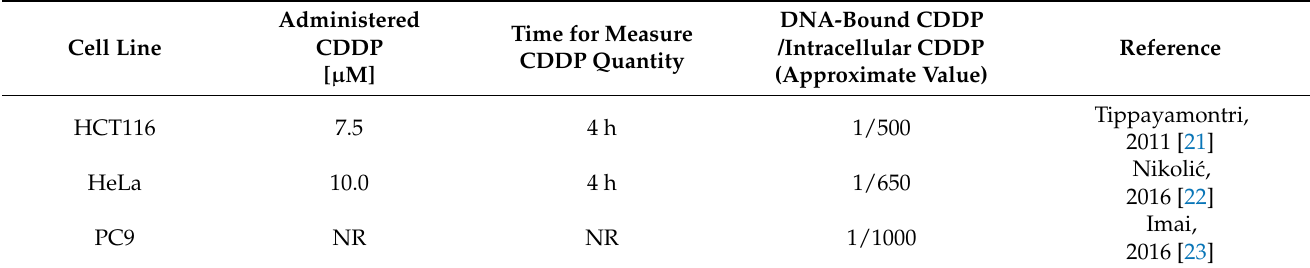
Table 1. Ratio of intracellular CDDP and DNA-bound